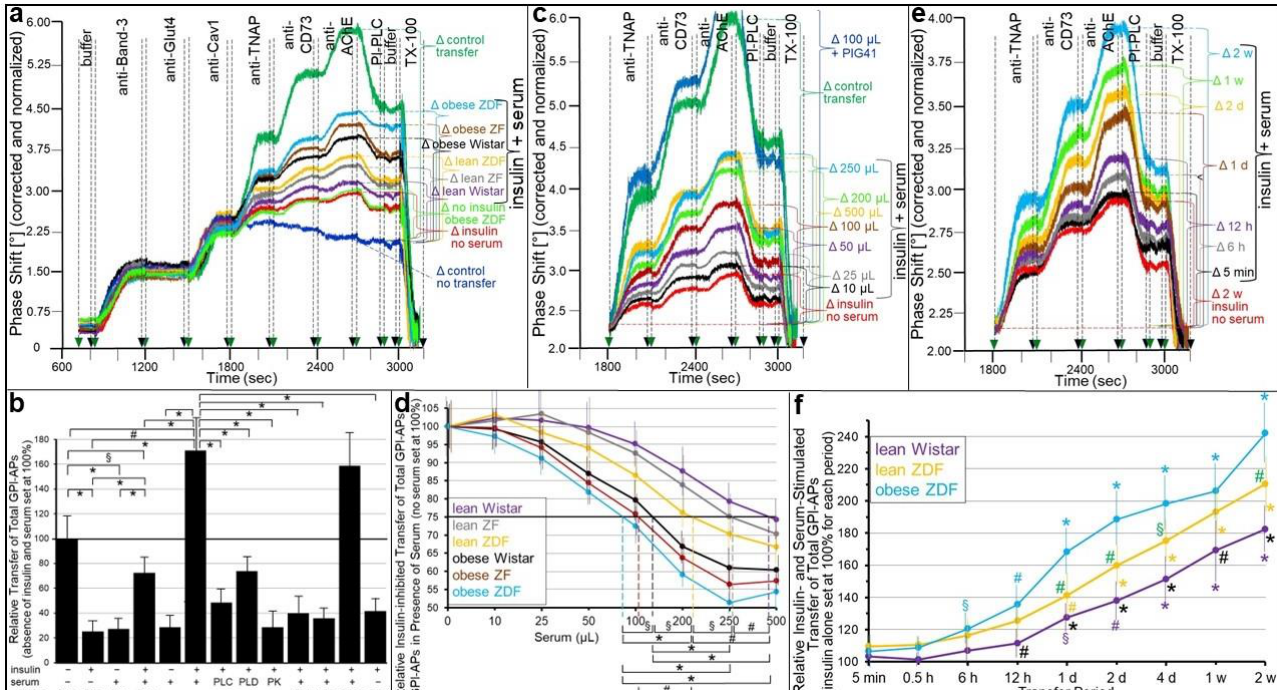
Figure 5. Restoration of insulin-inhibited GPI-AP transfer by serum. ( a – f ) Transwell co-cultures were run with human donor adipocytes (of lipid-loading stage II) or only medium (only a; control no transfer) and GPI-deficient EL acceptor cells in the insert and bottom wells, respectively, as described in Section 4. The co-cultures were incubated (37 ◦ C, 5 mM glucose) (( a – d ), 1 week; ( e , f ), increasing periods of time) in the absence (only ( a – c ); control transfer) or presence of human insulin (30 nM, ( a – f )) without ( a – c , e ) or with serum ( a , b , e , f , 100 µ L; c , d , increasing volumes; see brackets), which was prepared from lean or obese Wistar, ZF or ZDF rats ( a , d , f ) or obese ZDF rats ( b , c , e ) and then diluted 10-fold with PBS containing 2 mM Pha in the presence of Ca 2+ (4 mM) ( b ), Pha (1 mM) (( a – f , b ) as indicated) or PIG41 (100 µ M) ( c ). Thereafter PMs were prepared from the ELCs of the bottom wells, coupled to chips by ionic/covalent capture and then analyzed for the expression of membrane proteins by SAW sensing, as described for Figure 1. Phase shifts induced by the binding of antibodies against TMPs (800–1800 s; only shown for ( a )) and GPI-APs (1800–2700 s) and by subsequent PI-PLC and TX-100 treatments (2700–3200 s) are shown only, omitting the preceding capturing of the PMs (0–700 s). The serum was left untreated ( a – f ) or ( b ) digested with bacterial PI-PLC (PLC), human GPLD1 (PLD) or proteinase K (PK) or supplemented with α -toxin ( α Tox) or antibodies against TNAP, CD73 and AChE (Abs), each coupled to Sepharose beads or phenyl Sepharose beads (PhSe), as described in Section 4. In addition, BSA (4 mg/mL PBS) was added instead of serum ( b ). ( a , c , e ) Correction and normalization of the phase shift were performed as described for Figure 1. Phase shift ∆ between the start of injection of anti-TNAP antibody (at 1800 s) and termination of the injection of anti-AChE antibody (at 2700 s) are indicated by the horizontal, hatched lines and brackets for each incubation condition. ( b ) The experiment (see ( a )) was repeated three to five times (distinct co-cultures) and SAW sensing in quadruplicate. Phase shift ∆ induced by antibodies against TNAP, CD73 and AChE (1800–2700 s) were corrected for medium alone in the insert wells (see ( a ); control no transfer) and used for the calculation of the relative transfer of total GPI-APs in the absence of both insulin and serum (see ( a ); control transfer) set at 100%, with biologically relevant significant differences indicated. ( c , d ) The experiment (see ( b )) was repeated six times (distinct co-cultures) and SAW sensing in triplicate. Phase shift ∆ induced by antibodies against TNAP, CD73 and AChE (1800–2700 s) were corrected for medium alone in the insert wells ( c ) and used for the calculation of the relative insulin-inhibited transfer of total GPI-APs in presence of serum ( d ), with differences between the control transfer and transfer left in the presence of